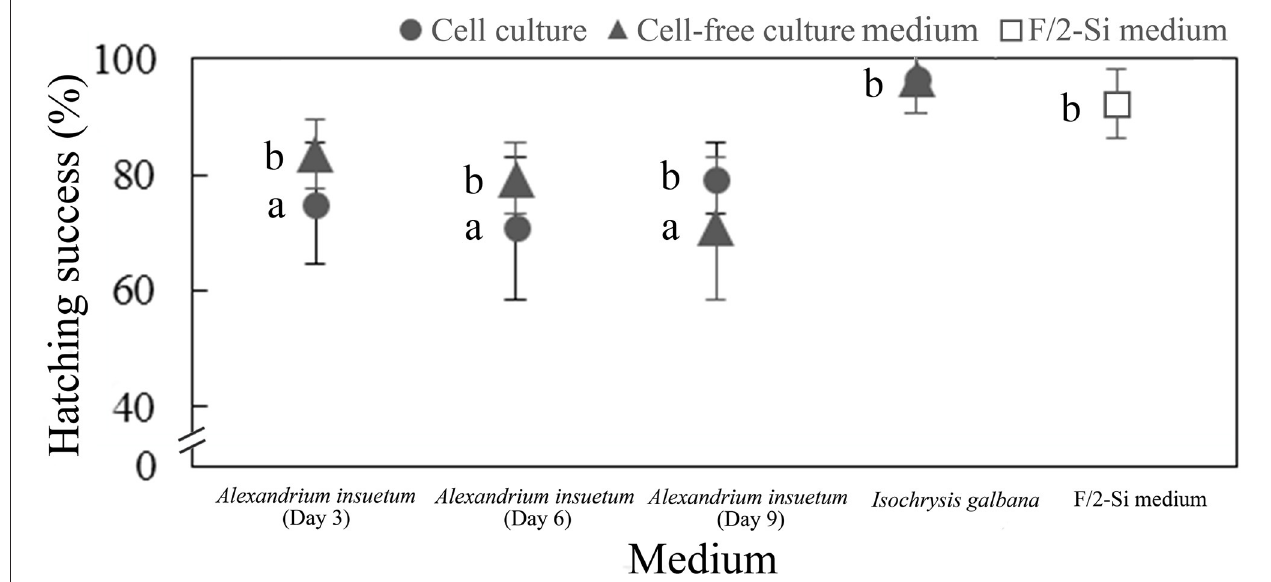
FIGURE 9 | Hatching success of rotifer resting eggs in the live cell culture (circle) and cell-free culture medium (triangles) at different growth stages (Day 3, 6, and 9) within 72h. F/2-Si medium and Isochrysis galbana (T-ISO) were used as negative controls. Data were shown as mean values ± SDs. The a and b letters next to bars indicated the post-hoc tests between the treatments with different letters denoting significant difference ( p < 0.05,